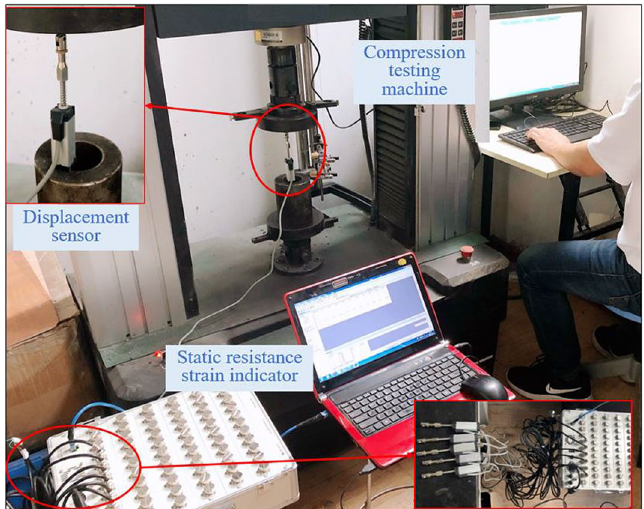
Figure 5. Displacement sensor and its calibration